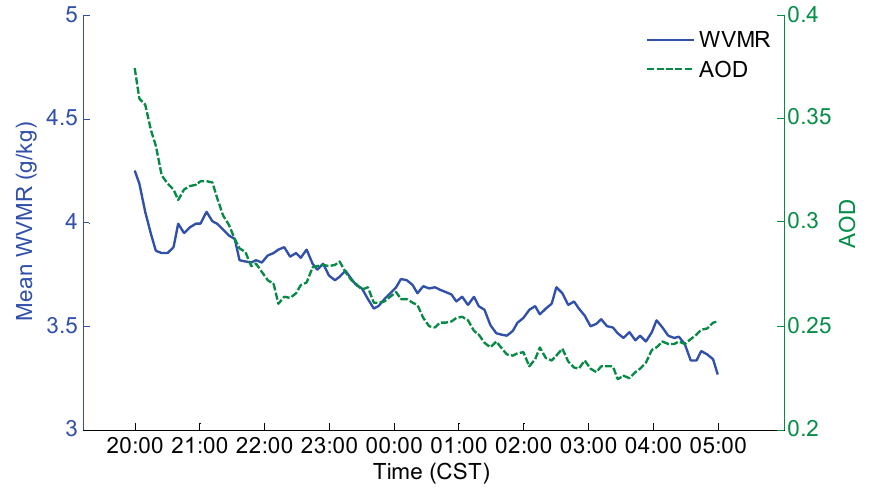
Figure 5. Mean WVMR and AOD from 0.5 km to 3 km retrieved by the RL at night, as denoted by a blue solid line corresponding to the left y-value and the green dotted line corresponding to the right y-value. The measured time was the same as that in Figure